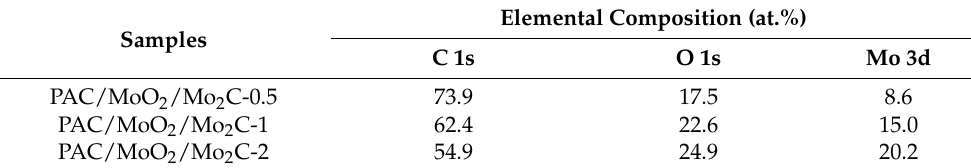
Table 3. Elemental composite of the PAC/MoO 2 /Mo 2 C ternary composites. Samples